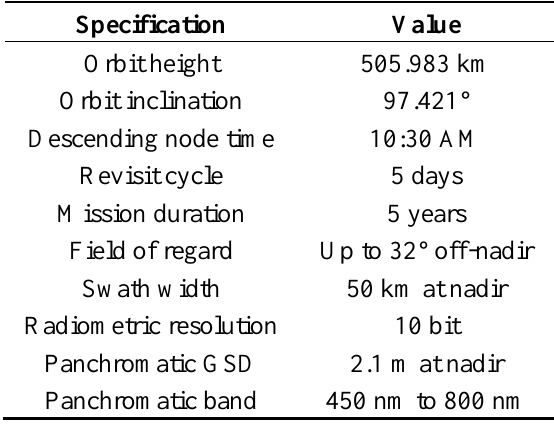
Table 1. Specifications of the ZY-3 (Ziyuan-3) satellite. GSD, ground sample